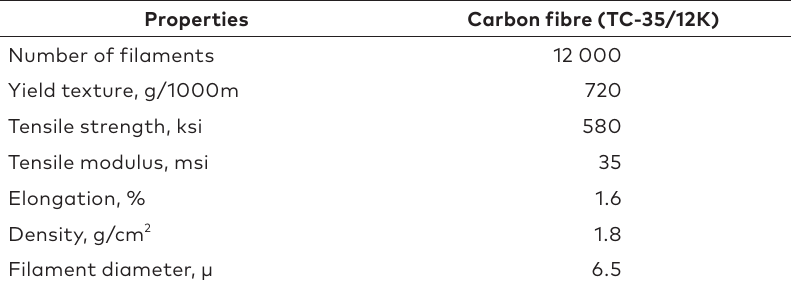
Table 4. Physical properties of carbon fibre